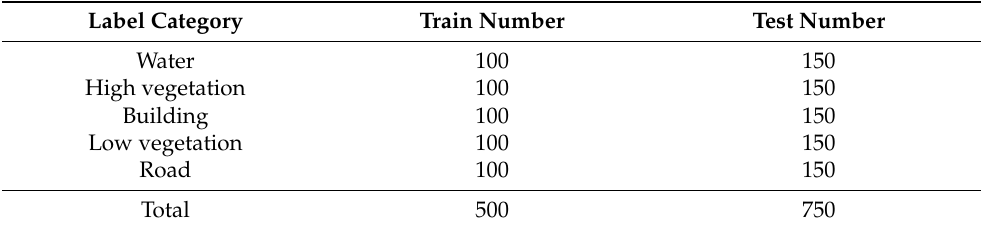
Table 1. Sample label type and quantity. Label